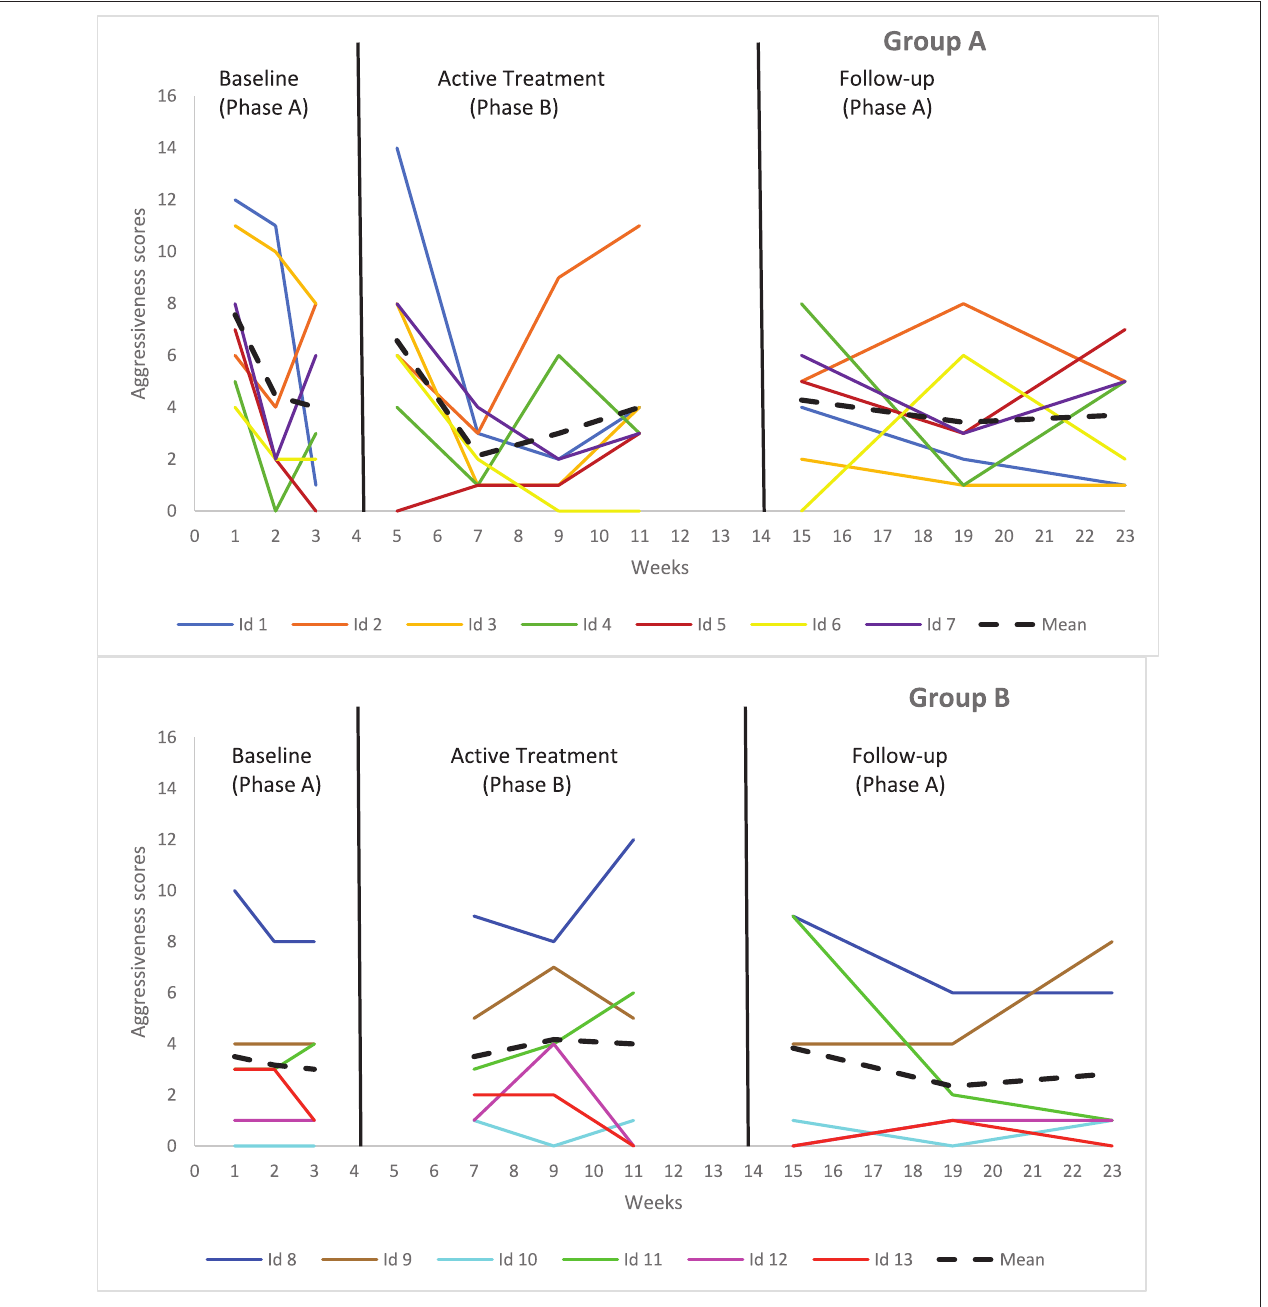
FIGURE 10 | Graphical display of baseline level and changes in level between consecutive phases in aggressiveness for teacher-reported